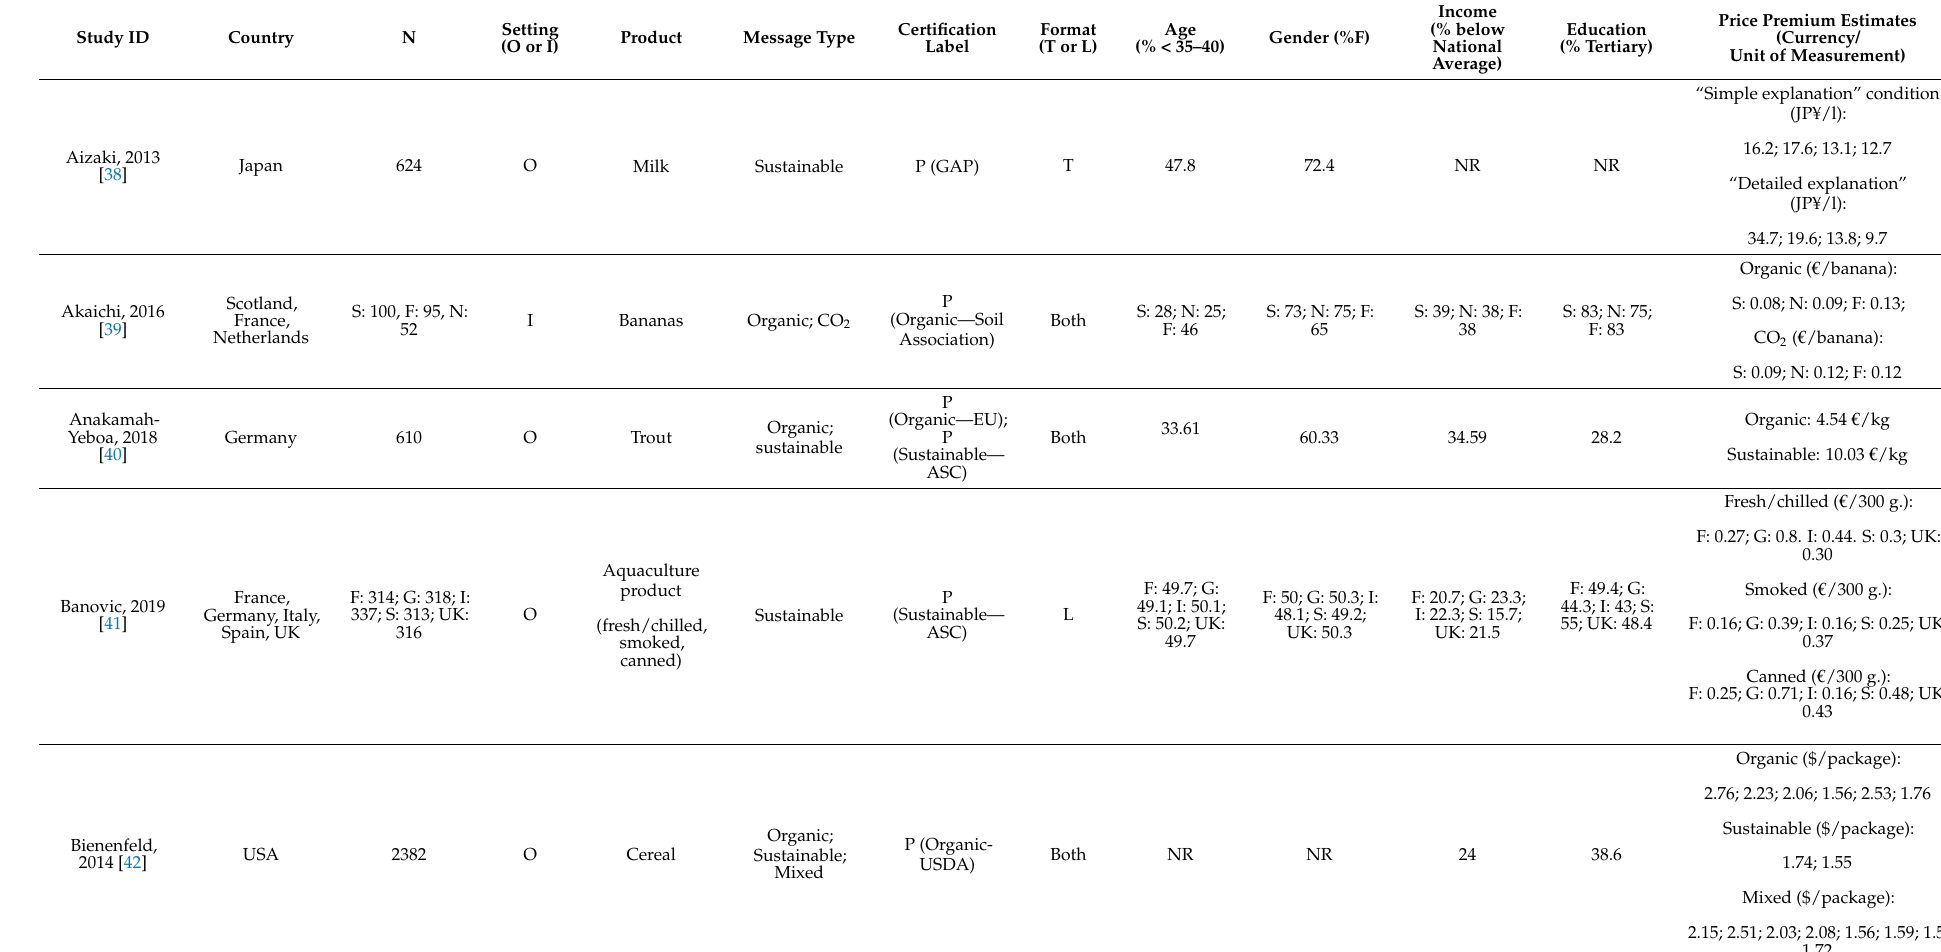
Table A1. Characteristics of studies included in the